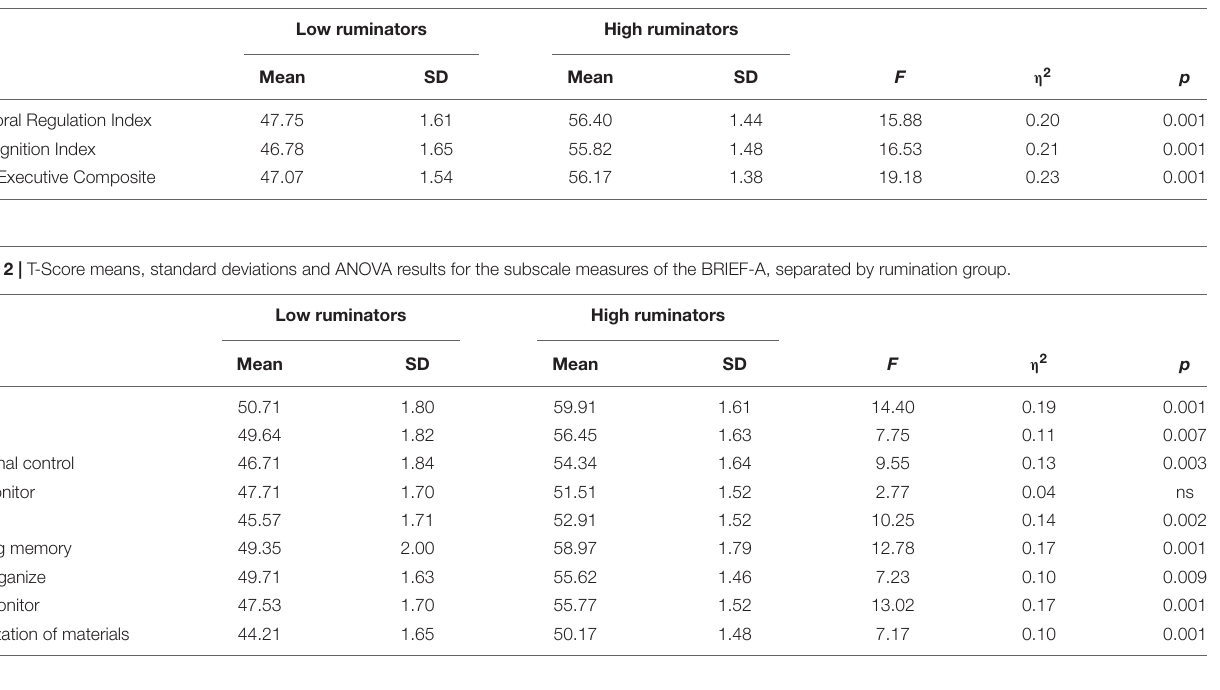
TABLE 1 | T-Score means, standard deviations, and ANOVA results for Behavioral Regulation Index, the Metacognition Index, and the combined Global Executive Composite (GEC) by rumination group.